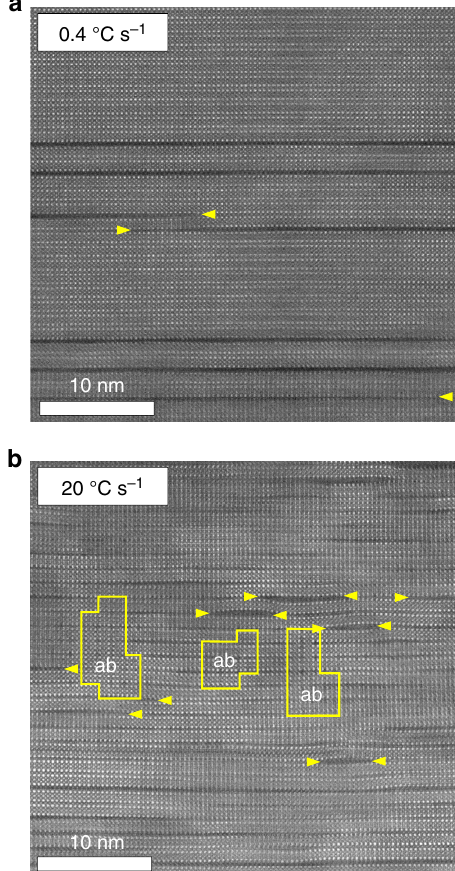
Fig. 4 STEM cross-section images of TLAG-YBCO fi lms highlighting the differences in microstructure for the T-route. a at a heating rate of 0.4 °C s − 1 , where highly epitaxial fi lm with a low density of defects (Y248 intergrowth) is shown, and b at 20 °C s − 1 heating rate, that shows a highly distorted YBCO matrix with a high density of short Y248 intergrowths and nanoscale ab grains. Yellow arrows indicate some of the Y248